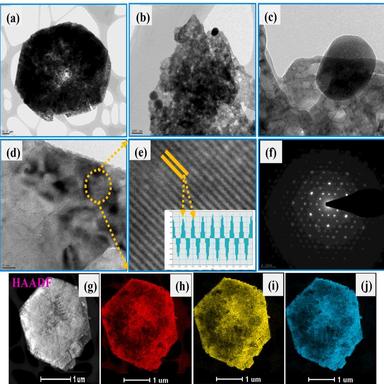
(a–c) TEM images, (d) HRTEM image, (e) d-spacing and the insets in (e) show the crystal interfaces and (f) SAED pattern (g) HAADF image (h-j) elemental mapping for resultant NCO-25 sample.